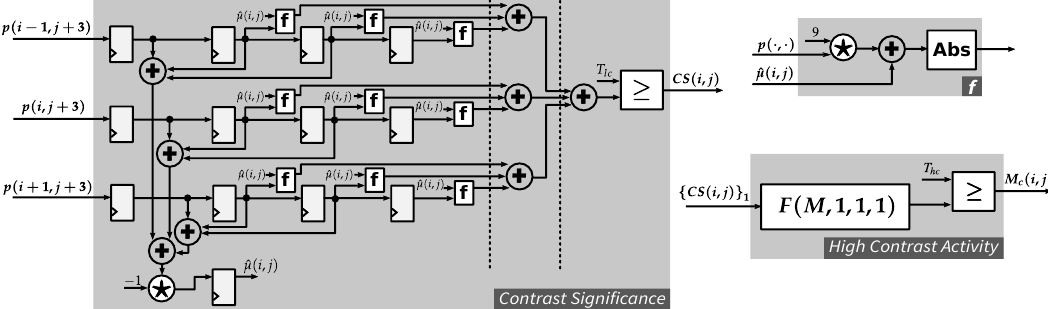
Figure 14. High-contrast activity module: ( Left ) contrast significance estimation module; ( Top-right ) function f ; and ( Bottom-right ) high contrast activity thresholding